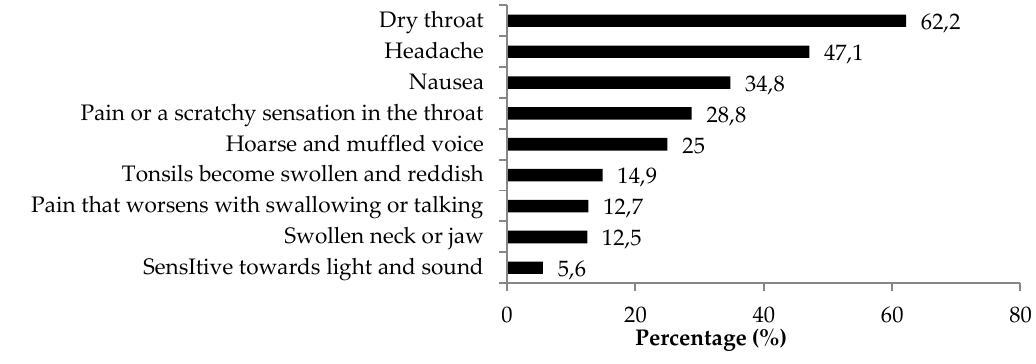
Figure 3. Adverse health effects associated with shisha use ( N = 503). Table 2. Association between shisha smoking practices and detrimental adverse health effects ( N =